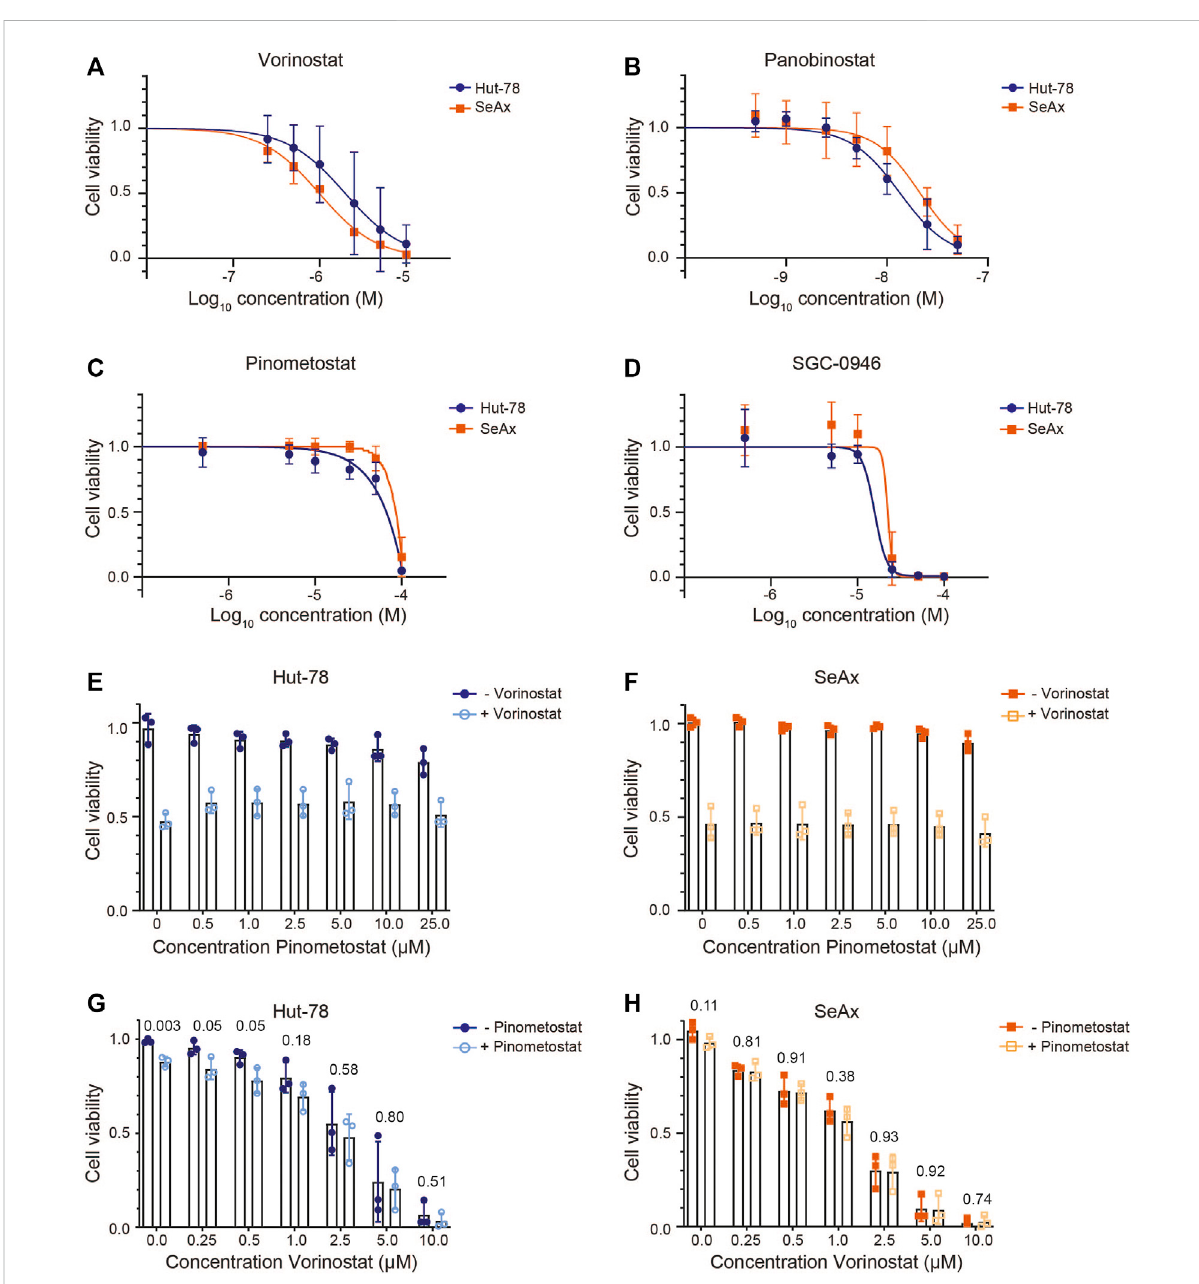
FIGURE 2 CTCLcellviabilityupontreatmentwithHDACinhibitorsand/orDOT1Linhibitors. (A – D) CellviabilityoftheCTCLcelllinesHut-78andSeAxafter 72 h of treatment with HDAC inhibitors Vorinostat (A) and Panobinostat (B) and DOT1L inhibitors Pinometostat (C) and SGC-0946 (D) . Points show average values of three independent biological replicates ±SD. (E – F) Cell viability of Hut-78 cells (E) and SeAx cells (F) treated with increasing concentrations of Pinometostat and with 2 µM Vorinostat (Hut-78) or 1 µM Vorinostat (SeAx) or without Vorinostat. Bar plots show average values of three independent biological replicates ±SD and individual data points. (G – H) Cell viability of Hut-78 (G) and SeAx (H) cells treated with increasing concentrations of Vorinostat and with or without 25 µM Pinometostat. Bar plots show average values of three independent biological replicates±SDandindividualdatapoints. p -valuesderivedfromunpairedstudent ’ st-testareindicated.CellviabilitywasdeterminedusingaCellTiter Blue assay and normalized against untreated cells. Each biological replicate represents the average of three technical